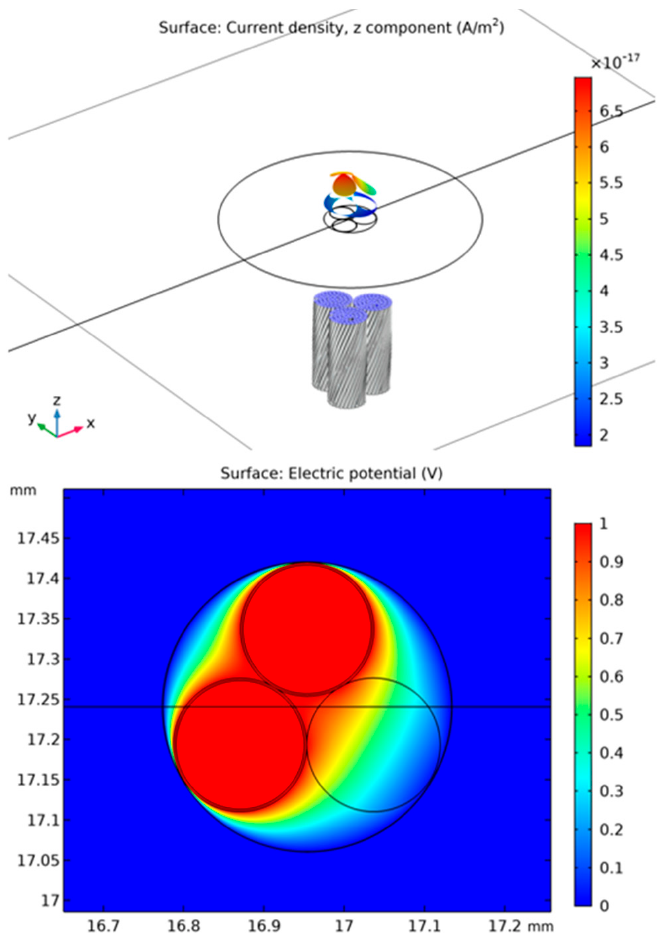
Figure 3. Out of plane current density, in comparison to the 3D model ( top ), and simplified 2D cross-section of the electric potential ( bottom ).